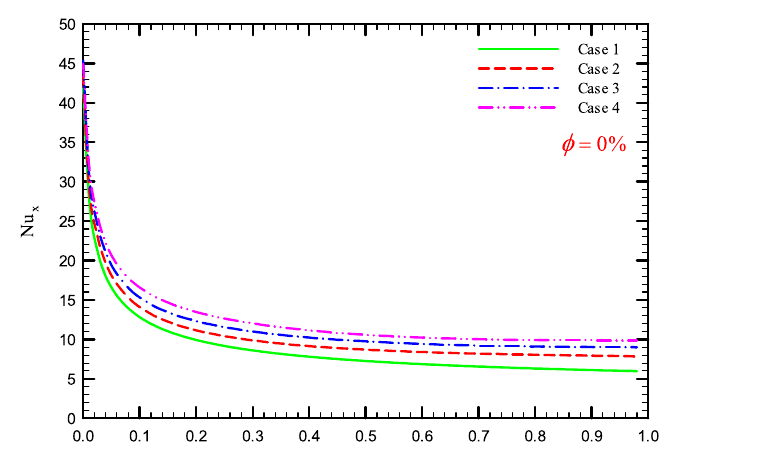
Figure 25. Nu loc versus dimensionless length in φ = 0% in Re = 250.